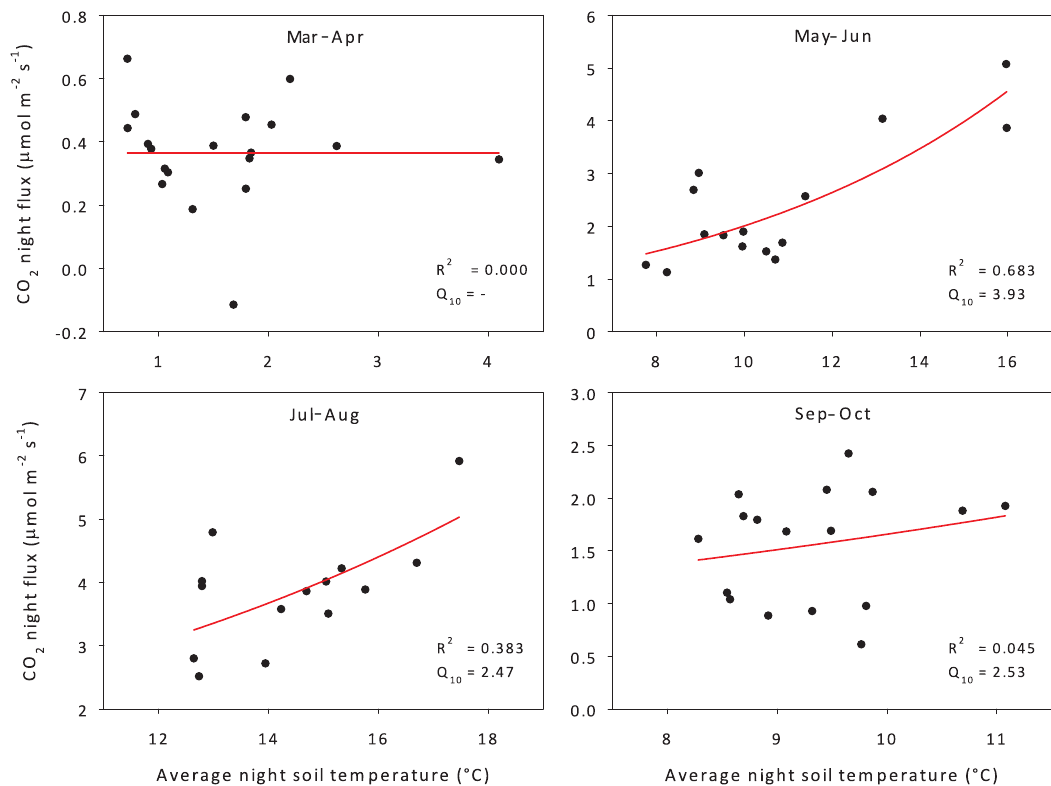
Figure 2. Average CO 2 night fluxes for every 2-month period during the growing season plotted against average night soil temperature (black dots) with the regression model outcome (red